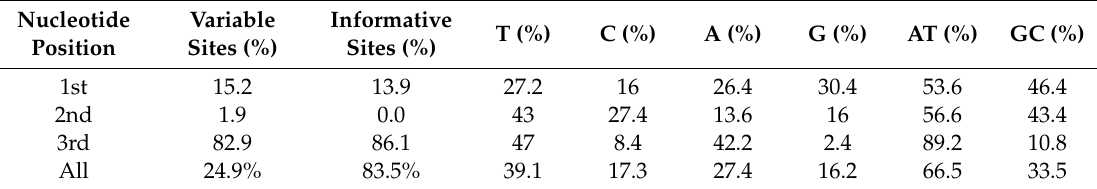
Table 2. Variable and informative sites, and average nucleotide composition in the aligned COI gene sequences.